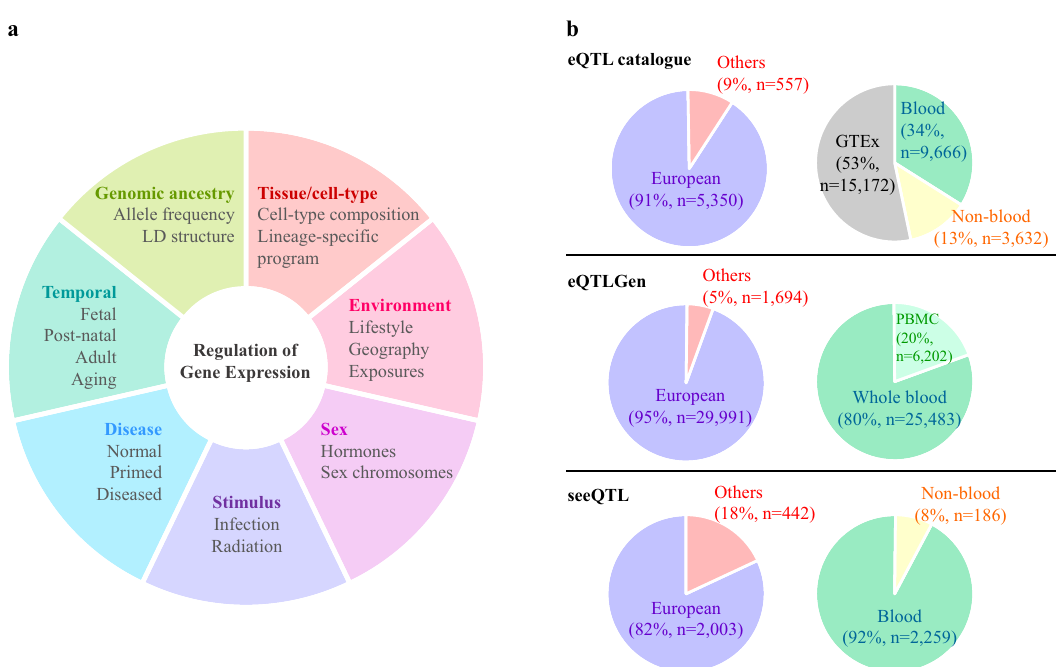
Fig. 1 Factors in fl uencing genetic regulation of gene expression and a current snapshot of eQTL resources. a Diverse factors and contexts in fl uencing genetic regulation of gene expression are highlighted. b Current statistics of ancestry and tissue/cell-type information from three representative eQTL dataset aggregation resources are summarized. Europeans in eQTLGen include studies of predominantly Europeans. Links to the resources are listed in Box